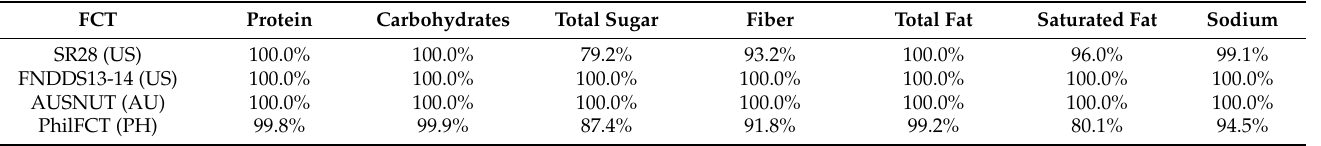
Table 1. Coverage of nutrients used in the regression model. SR = Standard Reference database from USDA; FNDDS: Food and Nutrient Database for Dietary Studies; AUSNUT = database used for the Australian nutrition survey.